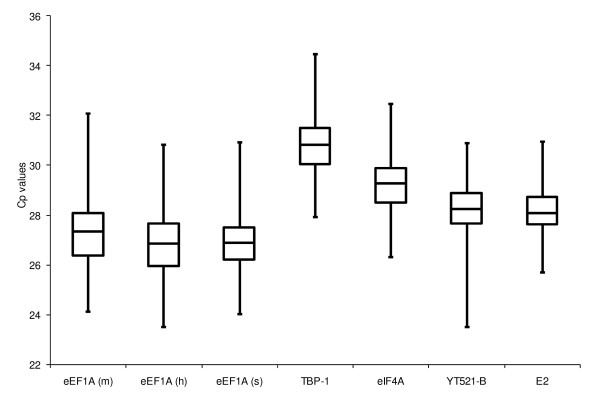
Crossing point (Cp) value variability in candidate reference gene comparisons for the 442 perennial ryegrass samples. Variability is displayed as medians (lines), 25th percentile to the 75th percentile (boxes) and ranges (whiskers).